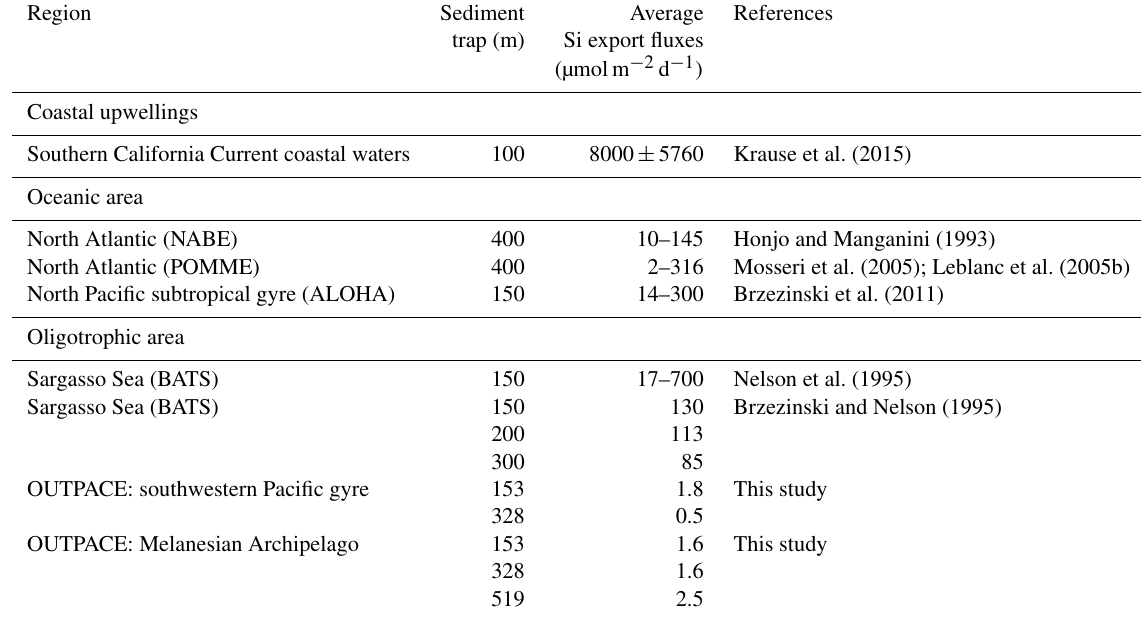
Table 6. Summary of Si export fluxes in sediment traps at various depths (in µmolSim − 2 d − 1 ) for the OUTPACE cruise compared to other